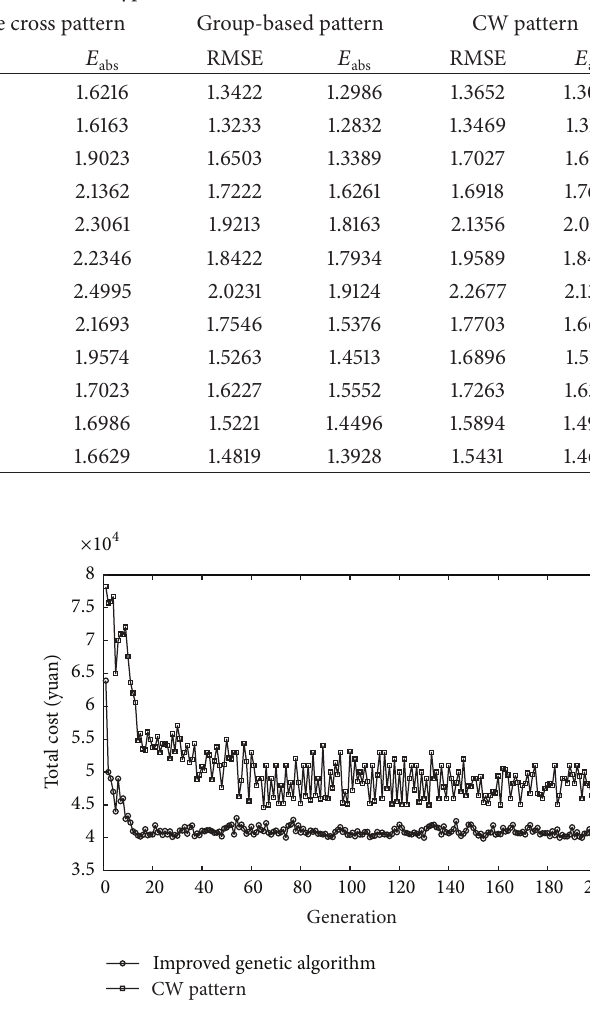
Figure 6: Population mean change contrasts of Group-based pattern.